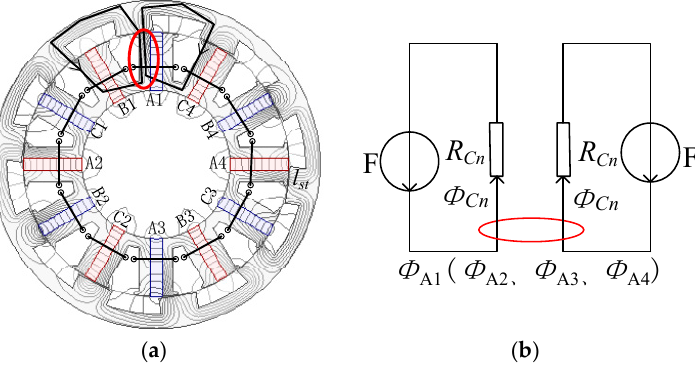
Figure 17. Negative extreme value of phase A flux linkage produced by PMs in COR-FSPM motor: ( a ) No-load magnetic field distributions; ( b ) Local equivalent magnetic circuit.